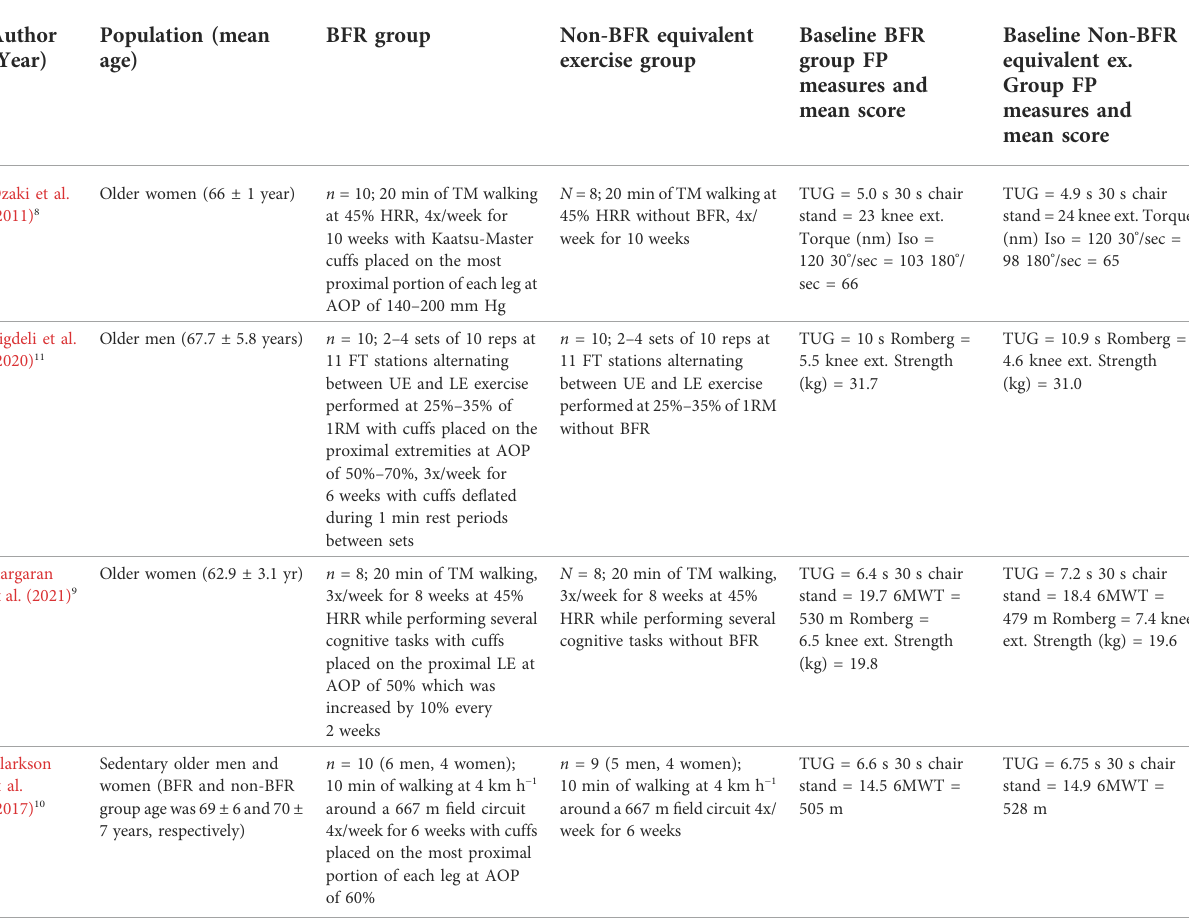
TABLE 2 Overall characteristics of participants per study.